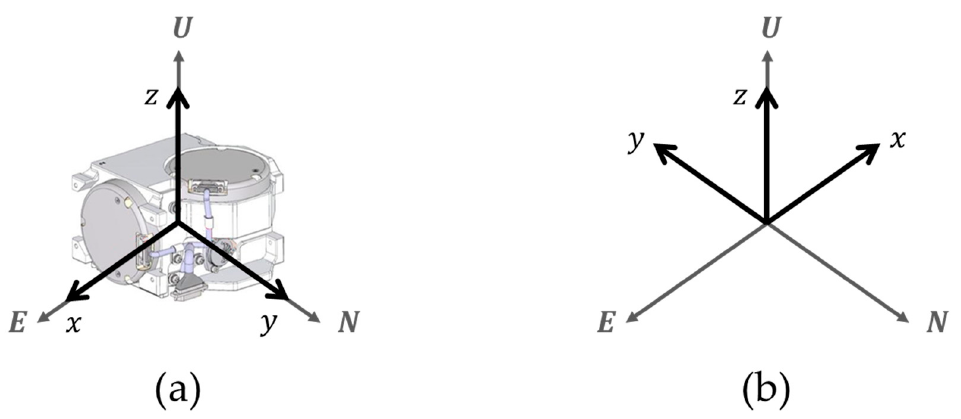
Figure 4. Rotation sequence in the Z − axis up position: ( a ) initial position; ( b ) position after rota- tion.